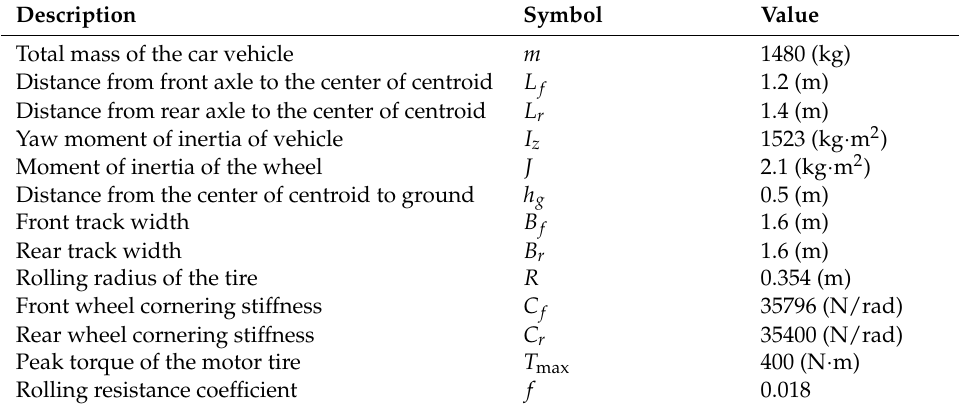
Table 2. Vehicle